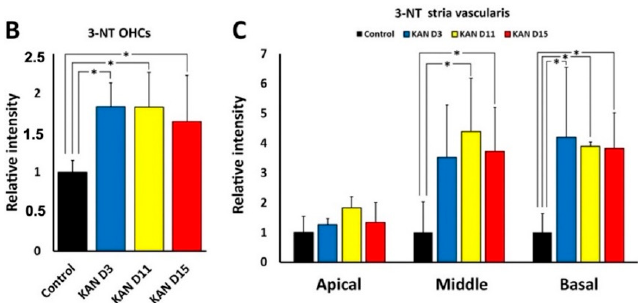
Figure 7. ( A ): Fluorescent immunolocalization of 3-NT (magenta) in the cochlea after ototoxic treatment with cisplatin (CDDP) and corresponding untreated control. Nuclei are counterstained in blue with DAPI. The vertical panel at the right of the illustration shows immunolabeling for 3-NT in the OHC region of the apical turn (small square, enlarged in the upper left corner of the photomicrography). The stria vascularis of the apical region can also be observed. The next two vertical panels show the lateral wall, including the stria vascularis of the middle and basal turns after 24 h and 72 h of cisplatin administration. Details are given in the text. ( B ): Relative immunolabeling intensity of 3-NT in the OHC region of the apical turn, 24 h and 72 h after administration of cisplatin. ( C ): Relative intensity of 3-NT immunolabeling in the stria vascularis of the apical, middle and basal turns, 24 h and 72 h after administration of cisplatin. Asterisks indicate statistical significance values, as specified in Section 2.6, Materials and Methods.